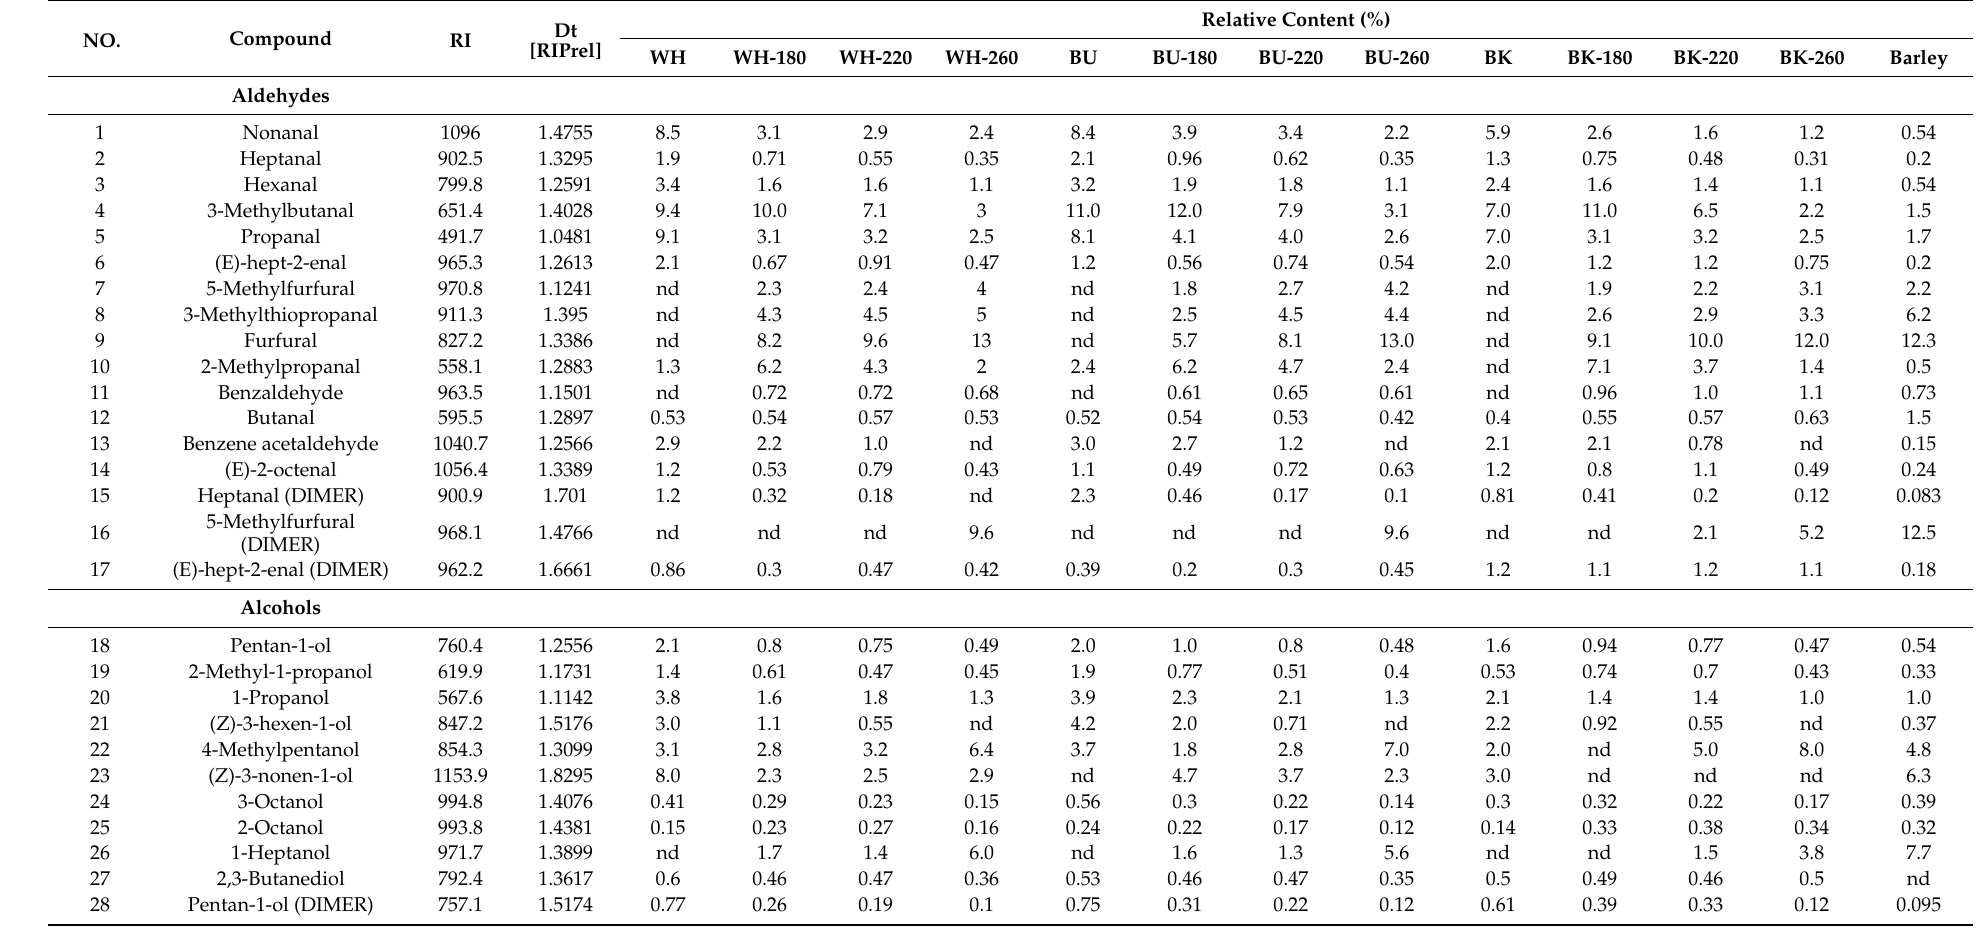
Table 2. Qualitative and quantitative analyses of volatile compounds in CHB roasted at different